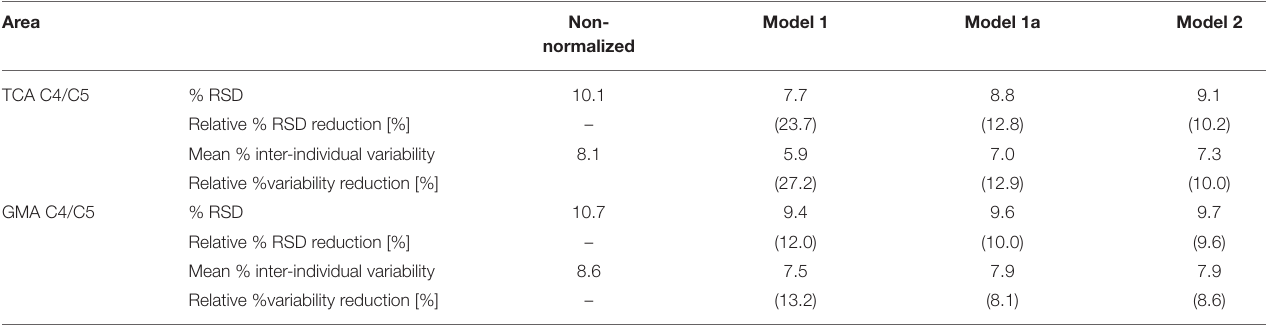
TABLE 4 | % relative standard deviation (RSD, standard deviation divided by the mean area), relative % RSD reduction, mean % inter-individual variability [(measured area in a given subject–group mean area)/group mean area], and relative % inter-individual variability reduction with respect to the measured total cross-sectional cord area (TCA) and gray matter area (GMA) at the intervertebral disc level C4/C5 for normalizations based on Models 1, 1a, and Model 2.